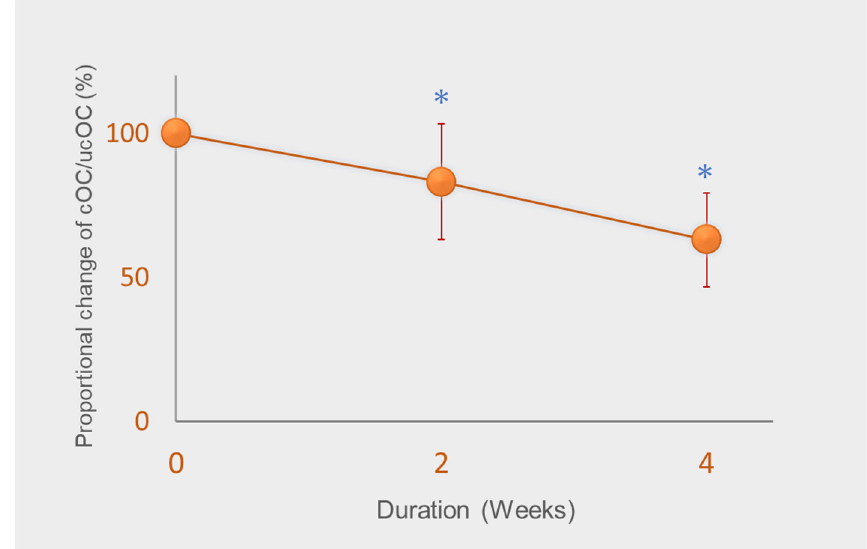
Figure 2. Change in the ratio of carboxylated osteocalcin (cOC) to undercarboxylated osteocalcin (ucOC) from baseline. Subjects were administered 72 µg vitamin K/day (around adequate intake of vitamin K) for four weeks. Data are expressed as mean ± standard deviation of 14–15 subjects. * Significantly different from baseline, p < 0.001. Adapted from [36].